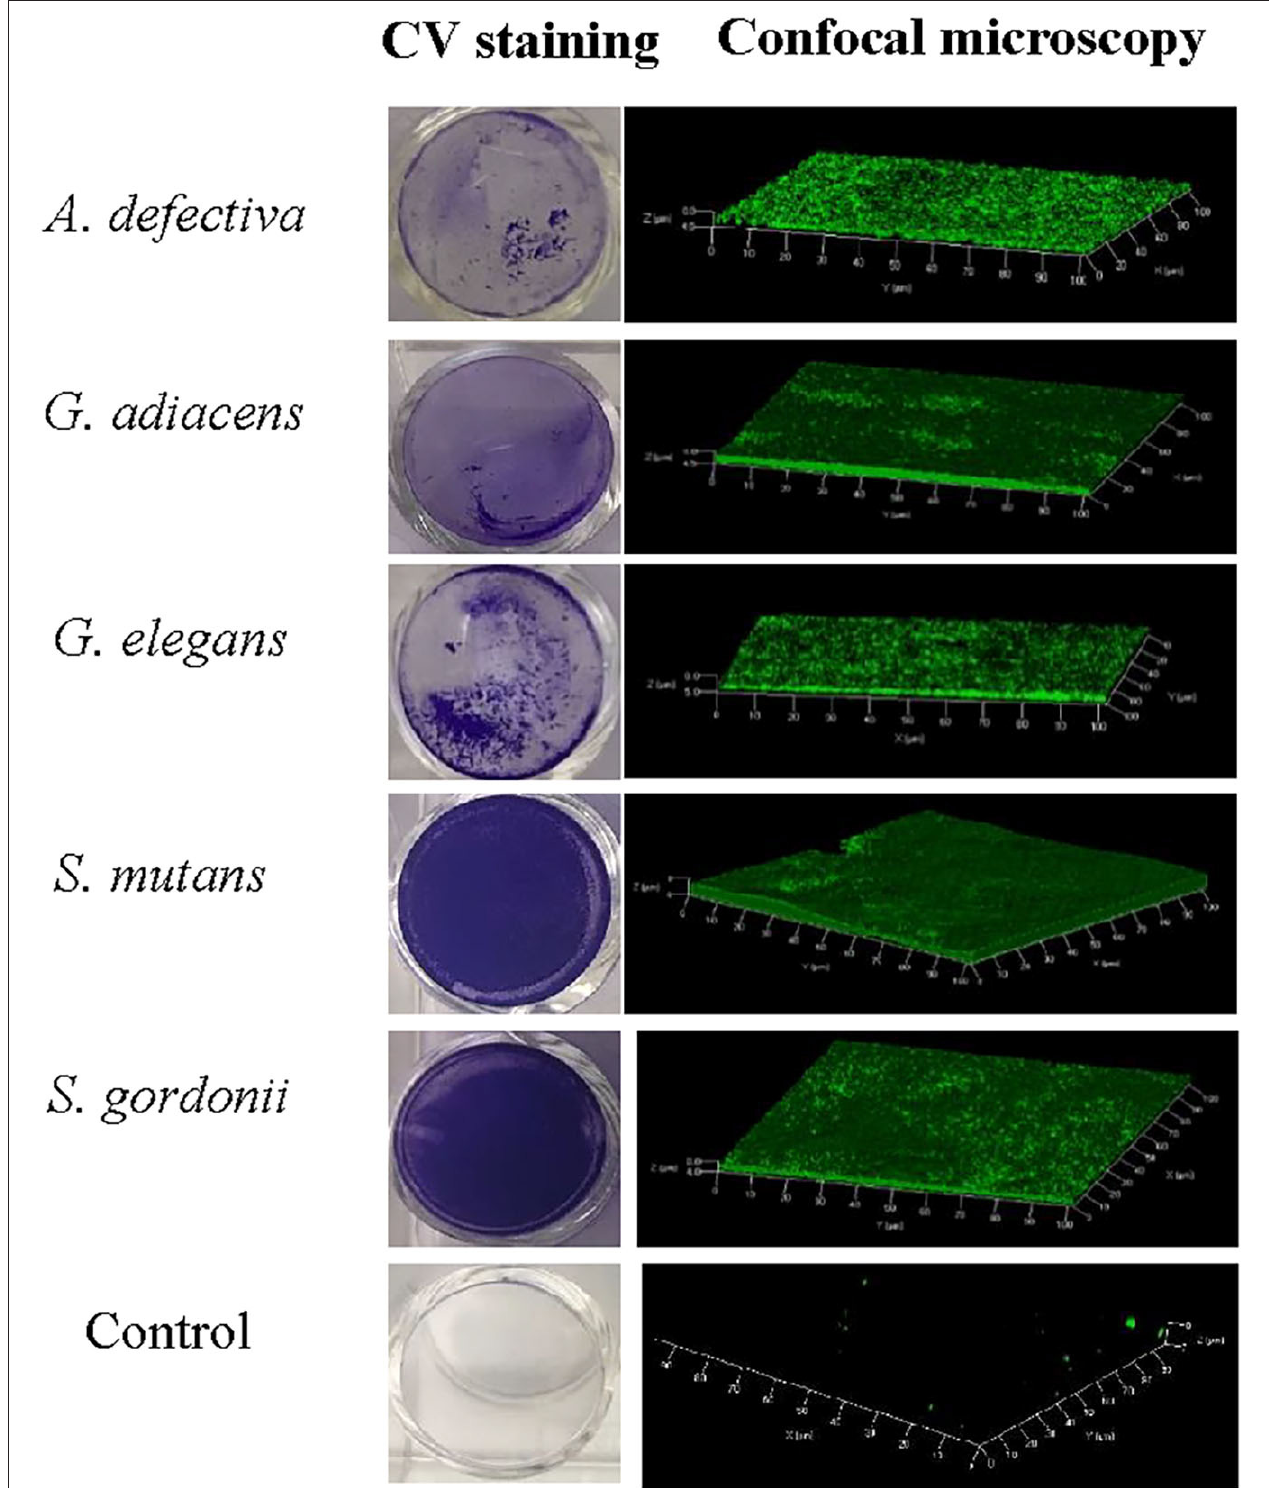
FIGURE 2 | Confocal microscopy and crystal violet staining of monospecies biofilms of five oral streptococcal species. For confocal microscopy, bacteria were cultured in brucella broth in the wells of Millicell ® EZ slides (Millipore) and stained with Syto9 ® . Images were acquired on Carl-Zeiss LSM 700 at 630 × magnification and 3D view reconstructed using the software ZEN 2012. The bacteria were grown similarly for crystal violet staining except that 24-well cell culture plates (BD Bioscience) were used.